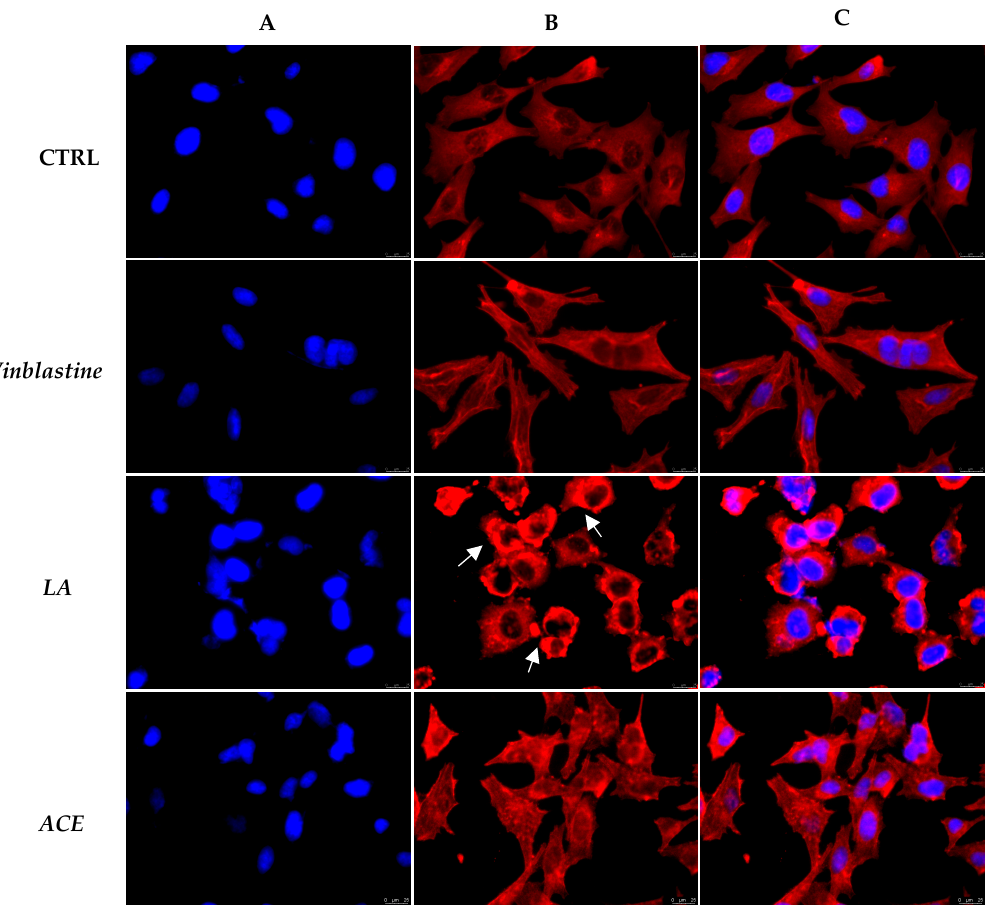
Figure 8. β -actin immunofluorescence analysis. A2058 cells were treated with ethanolic A. cherimola Mill. leaf extracts (ACE) at its IC 50 value, with Vinblastine at 1 µ M, with LA at 1 µ M or with vehicle (DMSO, CTRL) . Images were acquired at 40 × magnification. ACE induced a disorganization of the actin system with the presence of actin cables at the cell periphery, in a similar fashion to Vinblastine. ( A ) DAPI ( λ ex/em = 350/460 nm); ( B ) Alexa Fluor ® 568 ( λ ex/em = 644/665 nm); ( C ) overlay channel. Images are representative fields of three independent